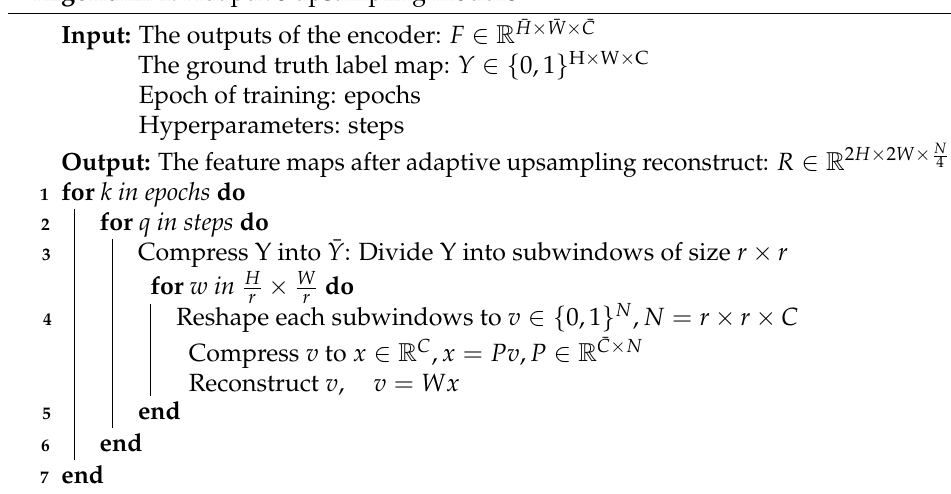
Algorithm 1: Adaptive upsampling